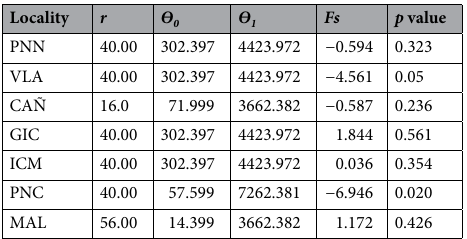
Table 5. Demographic parameters: r (generation number after expansion), Ѳ 0 (population size before expansion), Ѳ 1 (population size after expansion), Fs (Fu’s neutrality